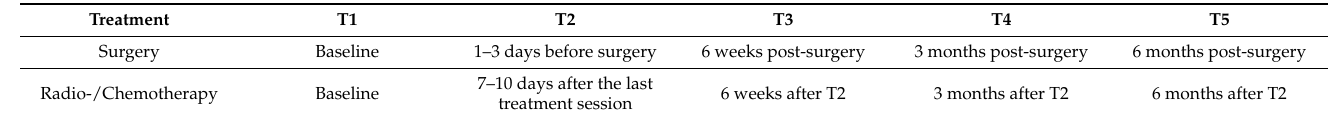
Table 1. Time points of data